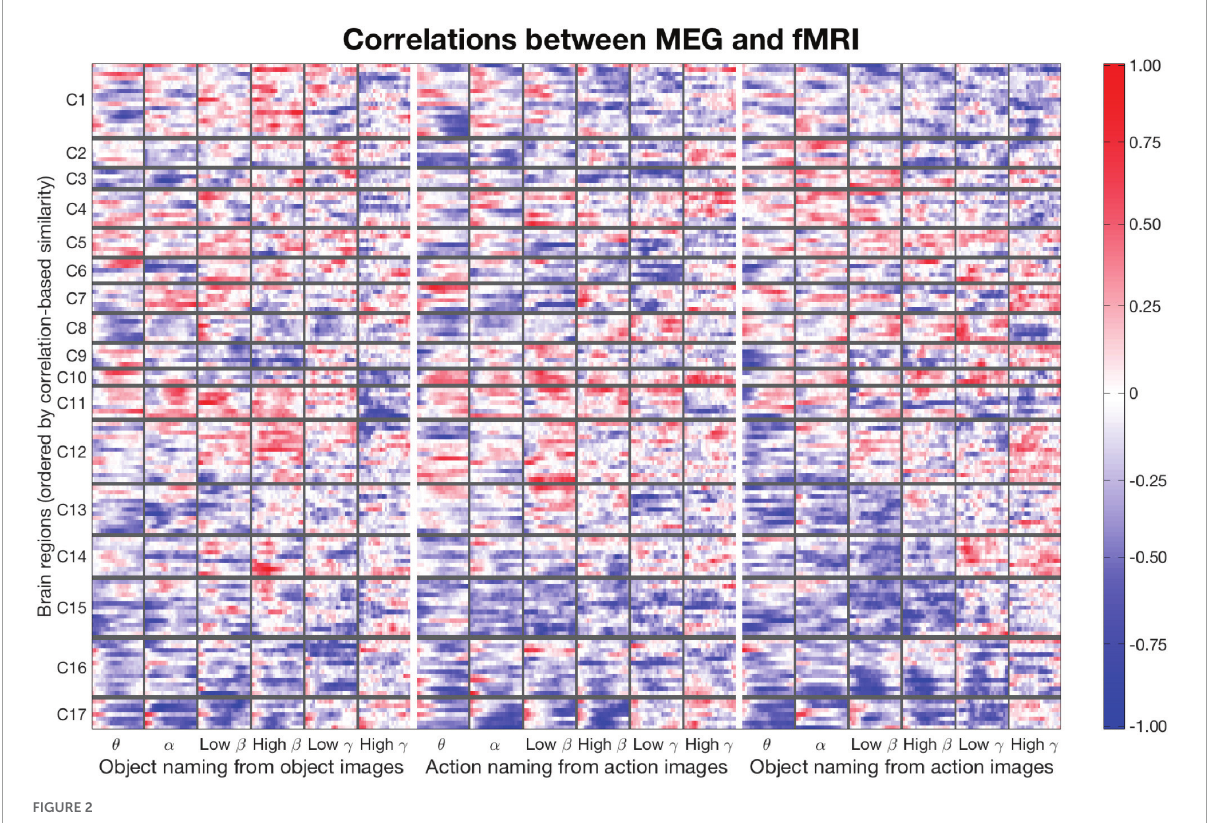
FIGURE2 Matrix of correlations between MEG and fMRI for the three experimental conditions (separated with thick white vertical lines). Each condition-related submatrix is divided into six frequency bands: Theta, alpha, low beta, high beta, low gamma, and high gamma, from left to right (columns separated by thin vertical gray lines). Each frequency band consists of a sequence of 22 time points (sub-columns). All 140 brain regions (70 per hemisphere) are displayed on the y -axis, ordered with respect to the optimal leaf order of a cluster tree. This leads to a solution where distances between similarly behaving brain regions are minimized. The brain regions (rows) are divided into 17 clusters (C1–C17, separated by horizontal thin gray lines; see Figure 3 for visualization of the areas on MRI). The clustering is the same for all three conditions. The color indicates the MEG-fMRI correlation strength (–1 ... +1), see scale on the